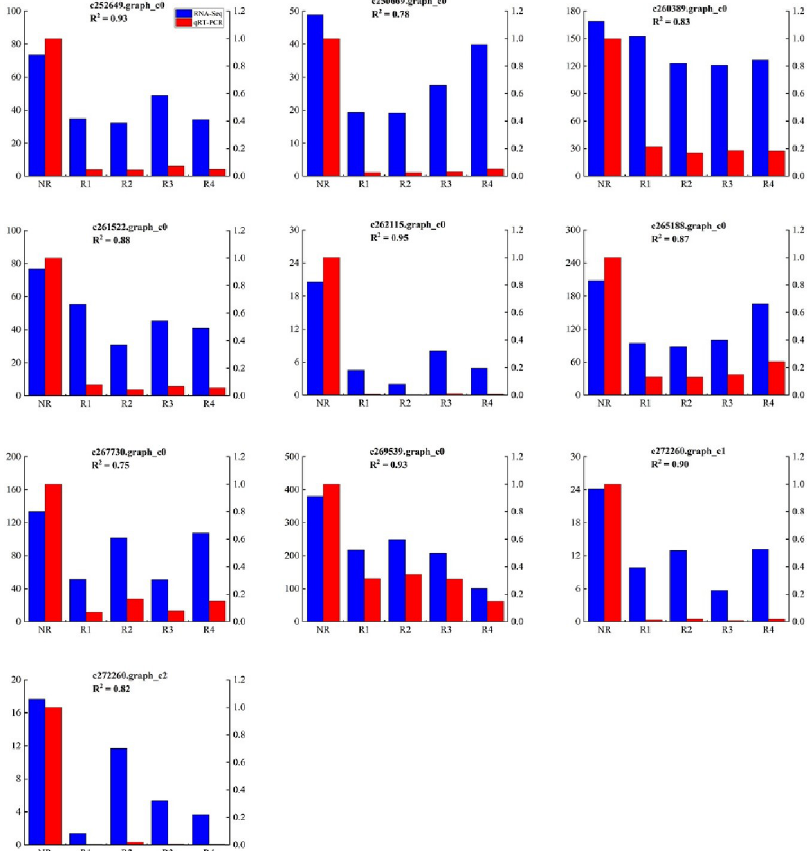
Fig 7. Comparison of qRT-PCR verification and FPKM value. The left y-axis indicates the FPKM value of ten differently expression genes in transcriptome. The right y-axis indicates the relative expression level of ten differently expression genes in